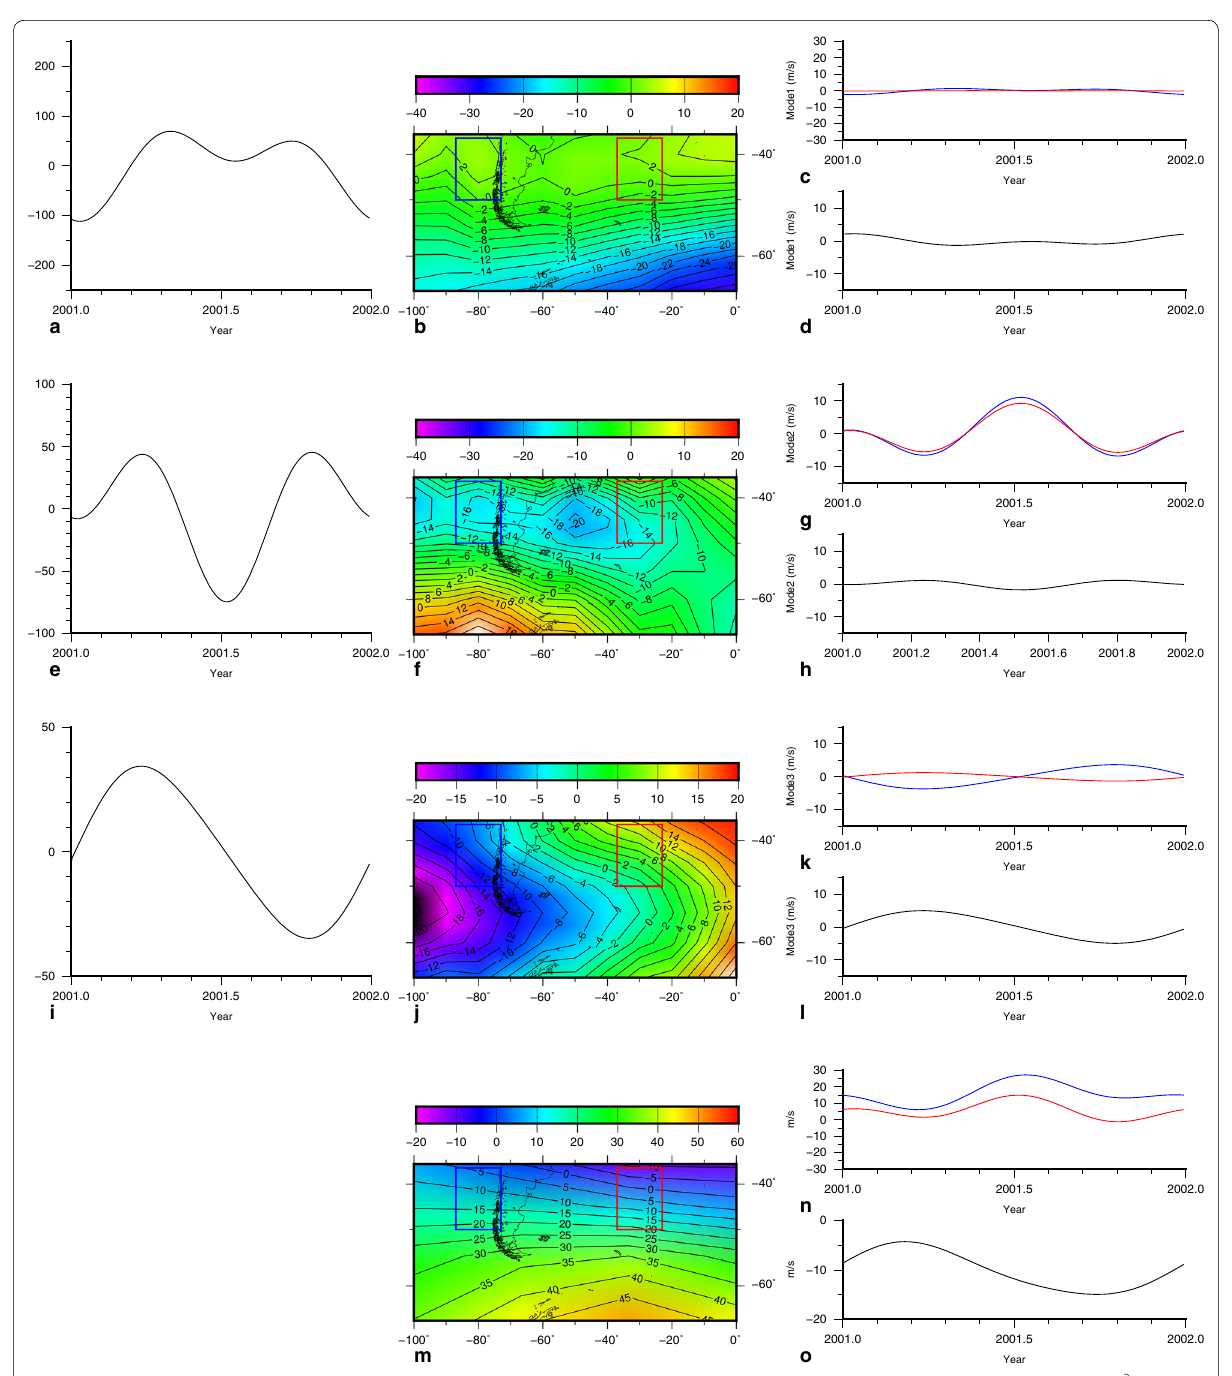
Fig. 8 V HWM07 over the South American region: a amplitude of the temporal variation, a 1 (the y -axis has to be multiplied by a factor of 10 − 2 ), b eigenvector or spatial variation, e 1 , c synthesized data for mode 1 ( a 1 e 1T ) for red (east) and blue (west) rectangles, d difference between red and blue · curves of c ; e the amplitude of the temporal variation, a 2 (the y -axis has to be multiplied by a factor of 10 − 2 ), f eigenvector or spatial variation, e 2 , g synthesized data for mode 2 ( a 2 e 2 T ) for red (east) and blue (west) rectangles, h difference between red and blue curves of g , i the amplitude of the · temporal variation, a 3 (the y -axis has to be multiplied by a factor of 10 − 2 ), j eigenvector or spatial variation, e 3 , k synthesized data for mode 3 ( a 3 e 3T ) · for red (east) and blue (west) rectangles, l difference between red and blue curves of k . Finally, the time-averaged ¯ V HWM07 ( x ) ( m ), the synthesized data, n ¯ V ∗ HWM07 ( t ) , for red (east) and blue (west) rectangles, and the difference ( d V ∗ HWM07 ( t ) ) between red and blue curves of n ( o